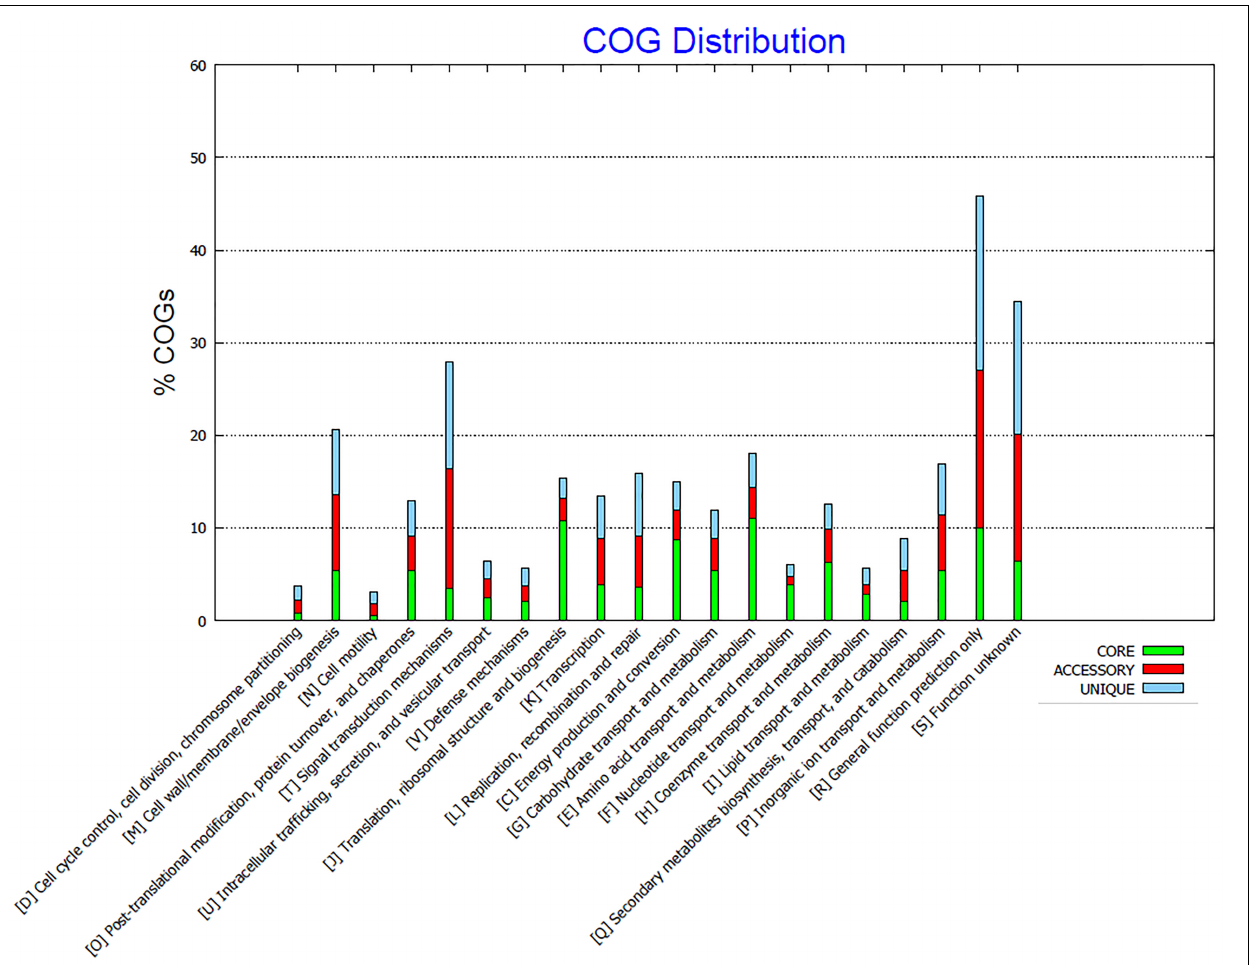
FIGURE 6 | COG distribution of core, accessory and unique genes present in all four analyzed Limnothrix genomes generated by Bacterial Pan Genome Analysis Tool (BPGA).